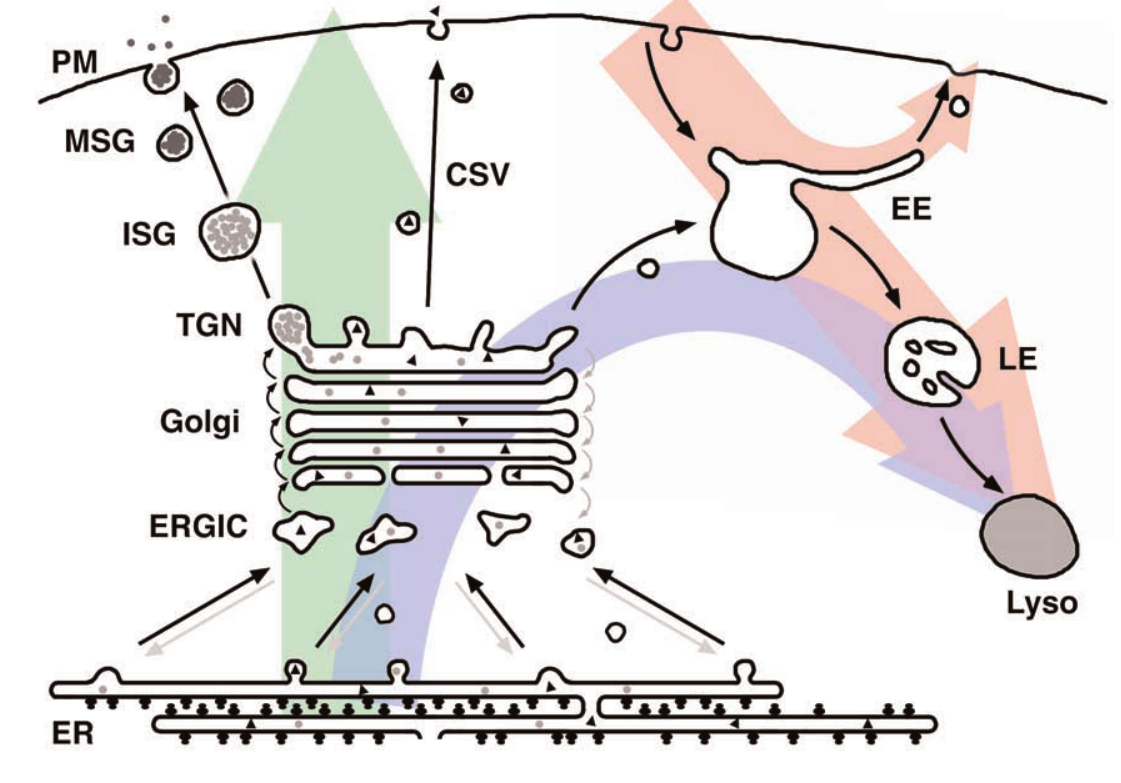
Secretory and endo- cytic pathways of eu- karyotic cells. The ER delivers membrane and proteins to the secretory and endo- cytic compartments of the cell as well as to the cell surface. ERGIC, ER-Golgi intermediate com- partment; TGN, trans-Golgi network; ISG, immature secre- tory granules; MSG, mature secretory granules; CSV, constitutive secretory vesicles; EE, early endosomes; LE, late endosomes; Lyso,